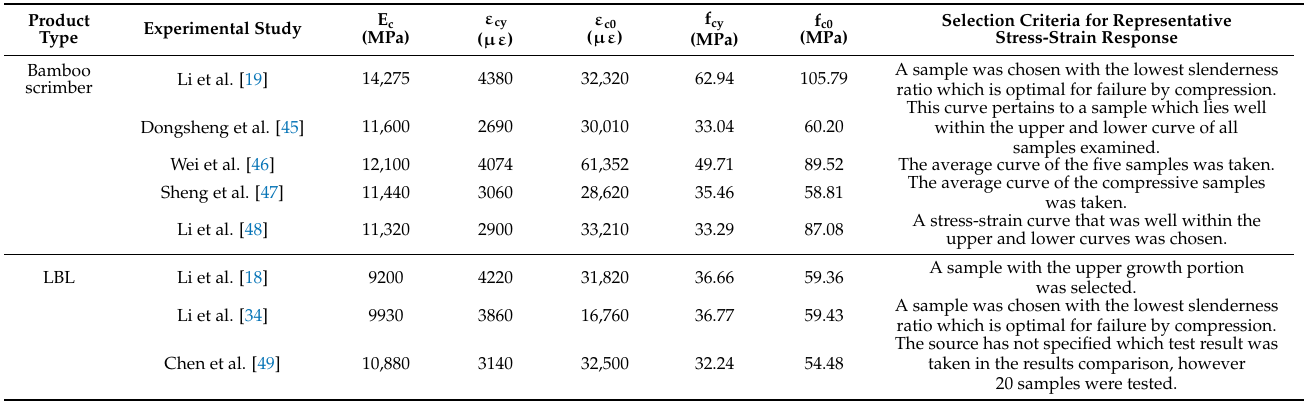
Table 3. Key material parameters extracted from the reported stress-strain